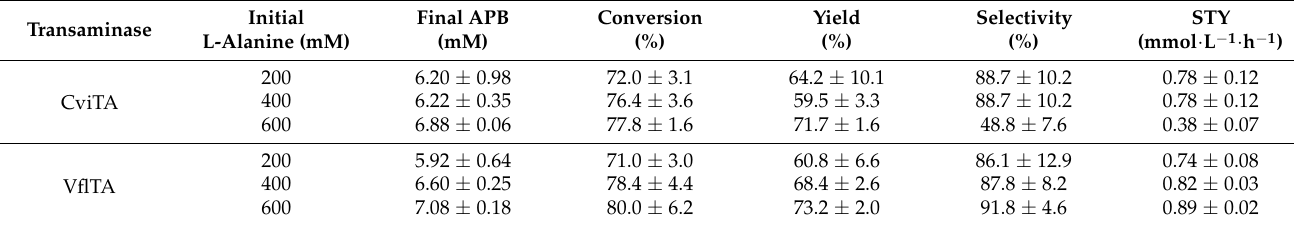
Table 4. Process metrics of 3-APB applying the multi-enzymatic system TA-PDC at different initial L-alanine concentrations. Reaction conditions: pH 7.5; 4-PB 10 mM; 30 ◦ C; TA 5% v · v − 1 ; PDC 25% v · v − 1 , 1 mM pyridoxal-5’-phosphate (PLP), 0.1 mM thiamine pyrophosphate (TPP), and 0.1 mM MgCl 2 .